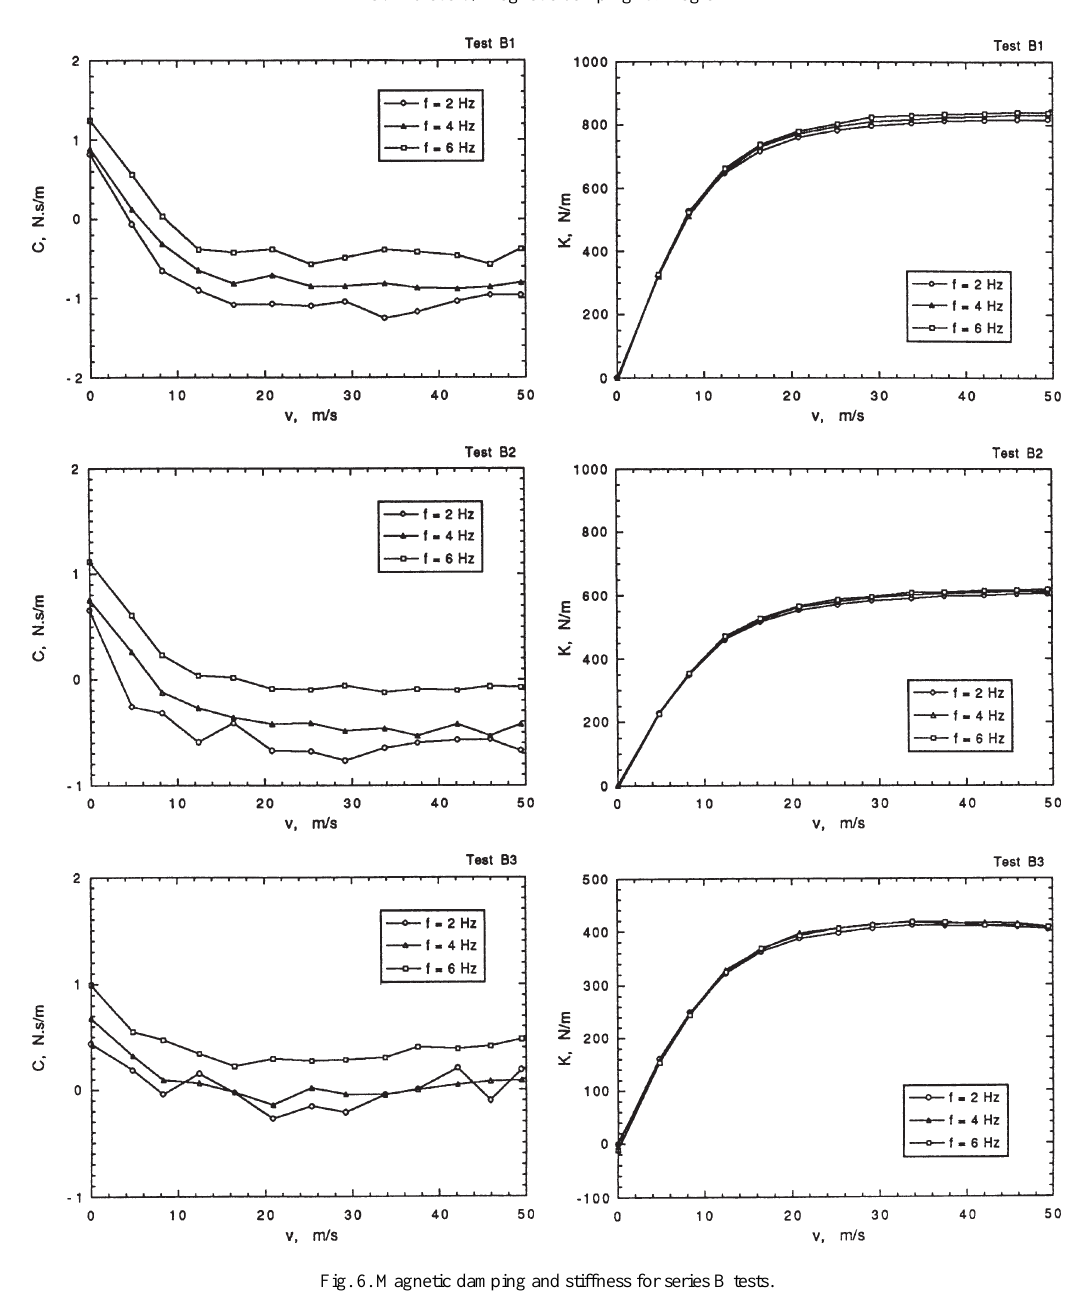
Fig. 6. Magnetic damping and stiffness for series B